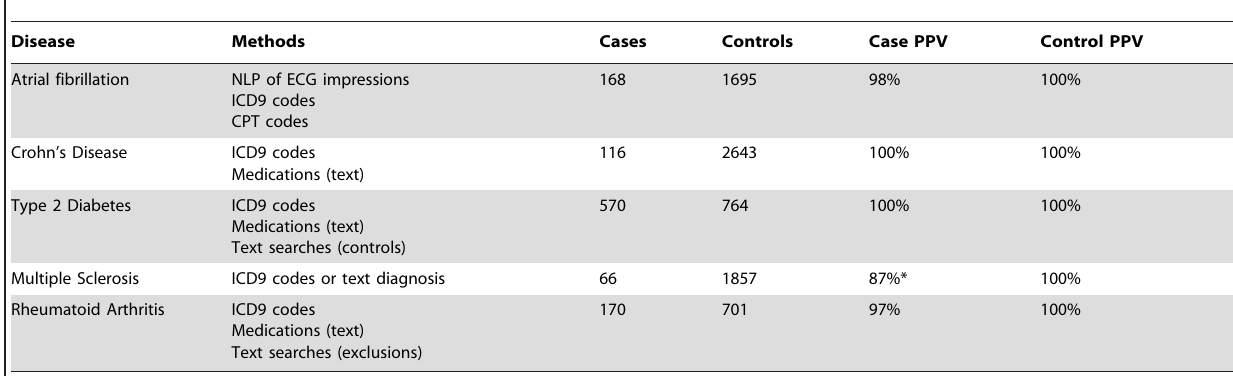
Table 2. Methods of finding cases and controls for genetic analysis of five common